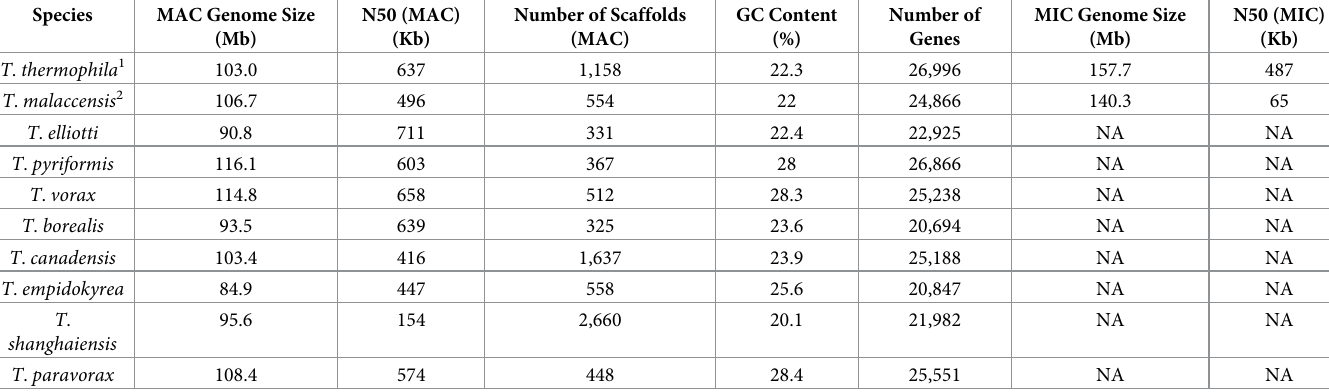
on ortholog clustering, all predicted protein-coding genes in each species were divided into 2 groups: conserved genes (represented in at least 2 species) and “species-specific” genes (repre- sented in only 1 species in our current sample). Proportions of species-specific genes range Table 1. Comparison of statistical data on the genomes of 10 Tetrahymena species. Species MAC Genome Size